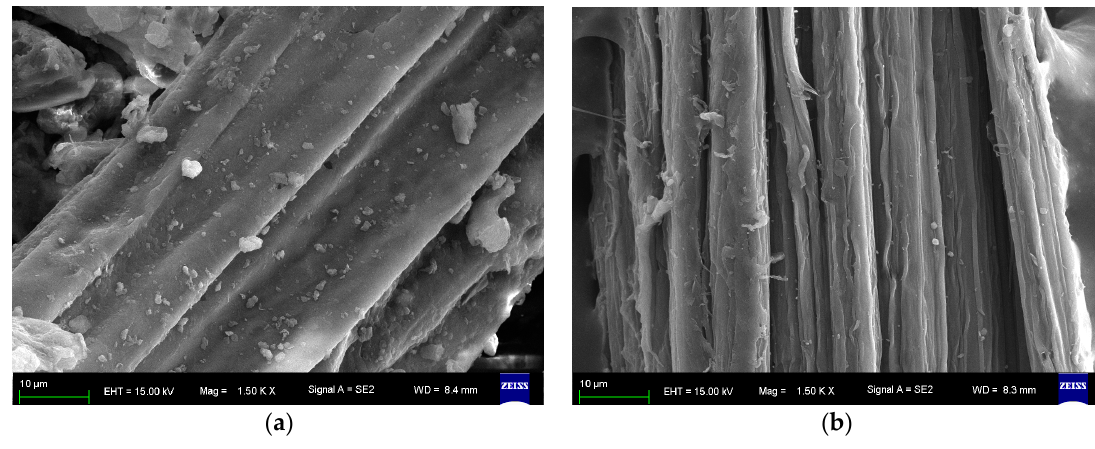
Figure 1. SEM image of ( a ) crude cow dung and ( b ) pretreated cow dung.